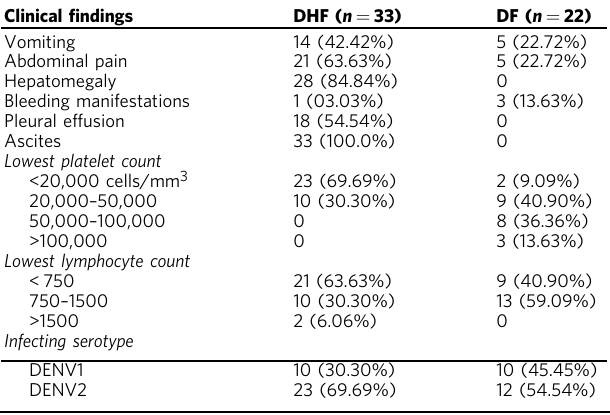
Table 1 Clinical and laboratory characteristics of secondary dengue patients with DHF and DF recruited for the study Clinical fi